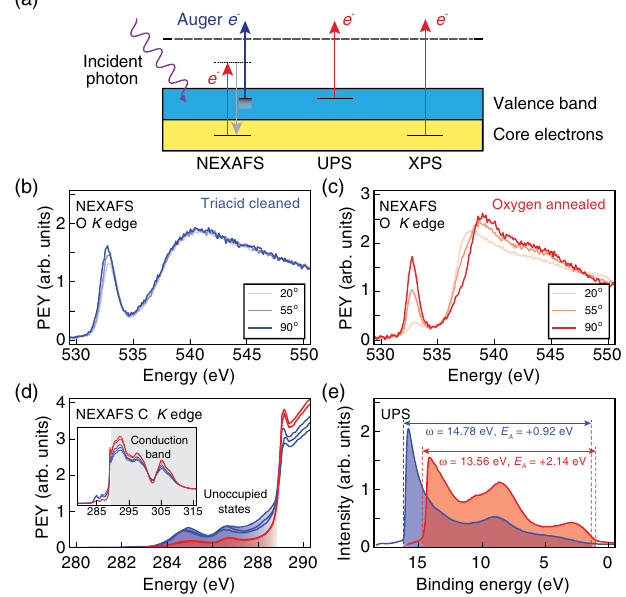
FIG. 3. Surface spectroscopy comparison between triacid- cleaned (blue) and oxygen-annealed (red) surfaces, (a) Schematic showing surface-sensitive spectroscopy techniques used to probe the diamond surface. (b),(c) Polarization dependence of NEXAFS spectra at the oxygen K edge. The polarization angle is defined relative to the surface normal. The y axis for all NEXAFS spectra is the partial electron yield (PEY), normalized and baseline sub- tracted (see Appendix A 5). The oxygen-annealed surface spec- trum exhibits strong polarization dependence, indicating that oxygen groups at the surface are well ordered. (d) NEXAFS spectra at the carbon K edge from three triacid-cleaned samples (blue curves) and two oxygen-annealed samples (red curves). Triacid-cleaned surfaces show a higher density of unoccupied states (shaded regions). The full energy range is shown in the inset. (e) UPS spectra with excitation energy h ν ¼ 21 . 2 eV of the triacid-cleaned (blue) and oxygen-annealed (red) surfaces. The spectral width ω is indicated by the shaded regions. The oxygen- annealed surface exhibits a higher positive electron affinity E ( þ 2 . 14 eV) than the triacid-cleaned surface ( þ 0 . 92 eV).